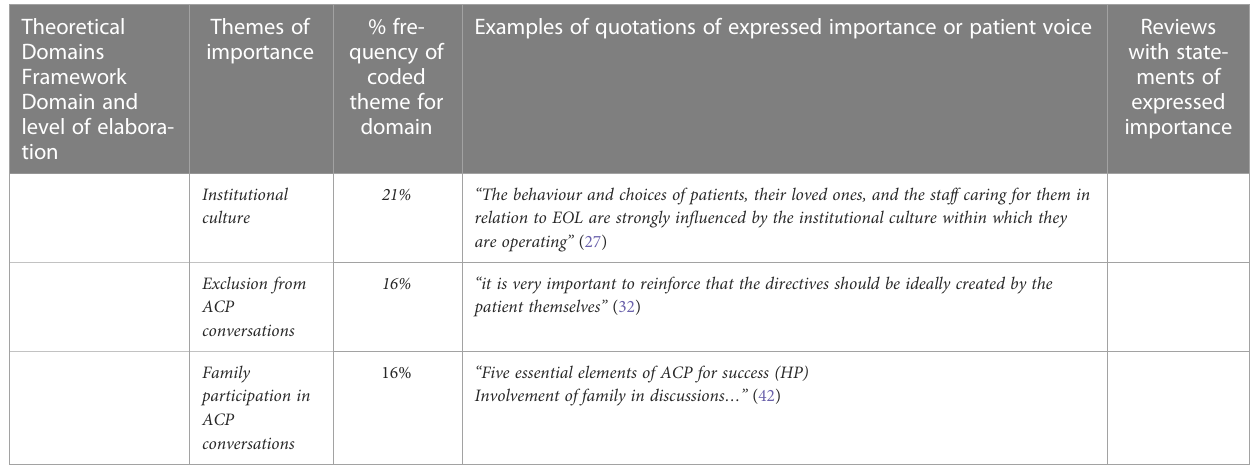
Figure Legend Intervention target Interaction between